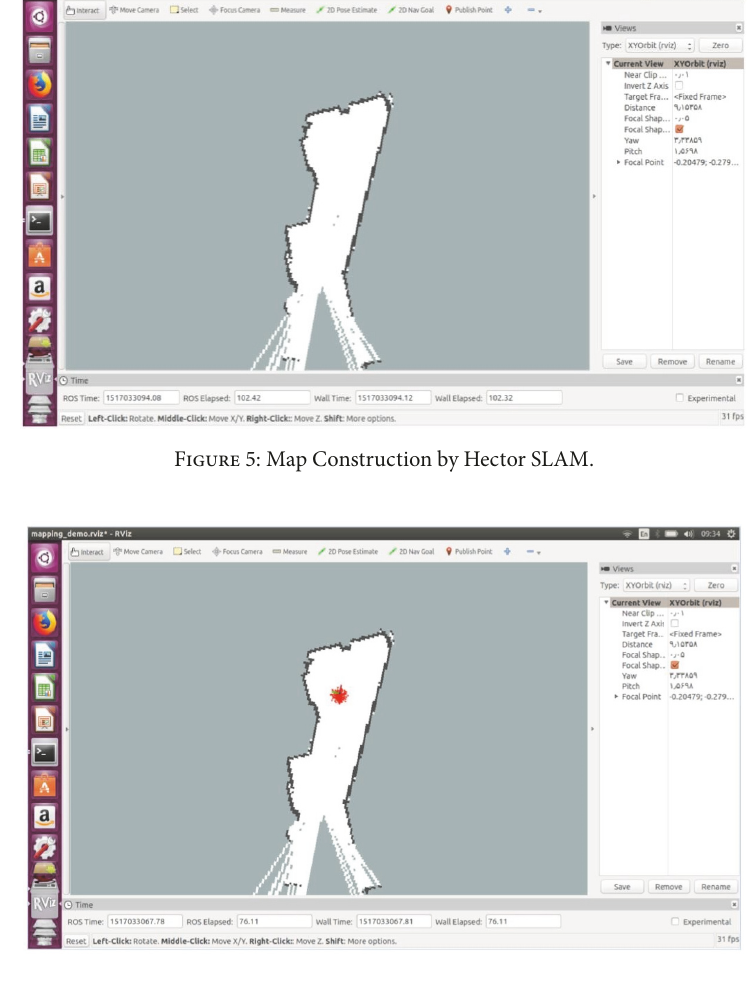
Figure 6: Representation of robot position using hybrid Particle Filter and Finite Impulse Response in